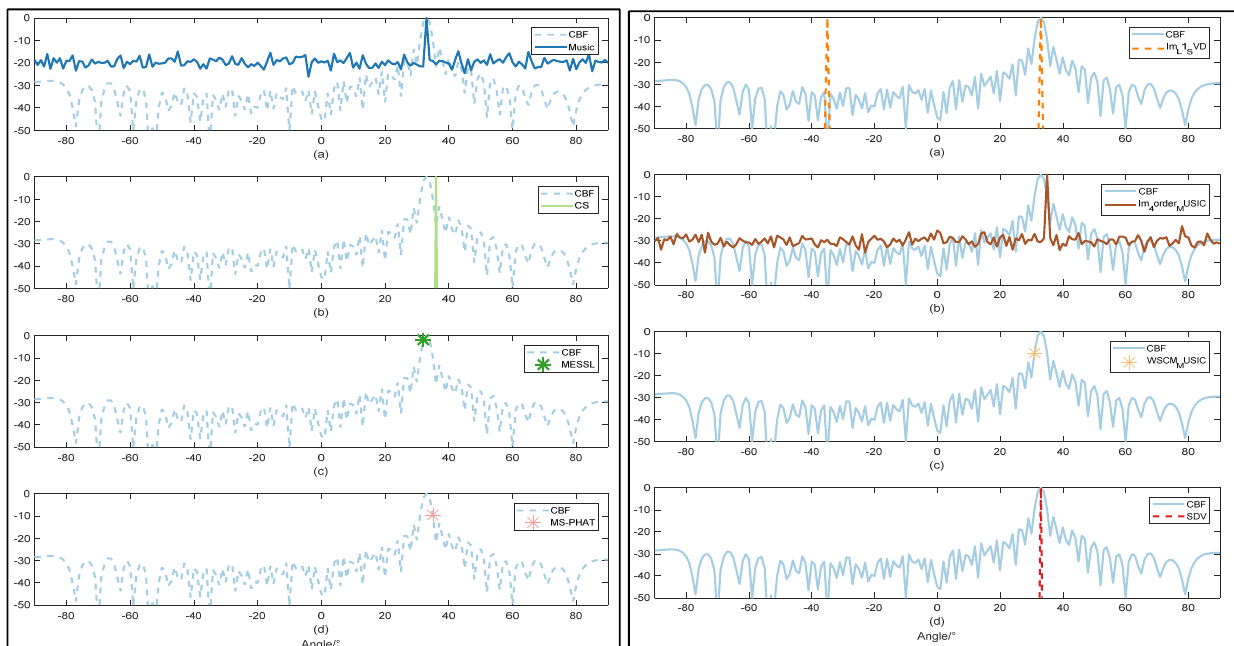
Figure 6. Comparison of direction estimation with SNR = 10 dB by 9 methods: CBF worked as a comparison in all figures. Music are shown in left ( a ) CS are shown in left ( b ). MESSL are shown in left ( c ) and MS-PHAT are shown in left ( d ). Im-L1-SVD are shown in right ( a ). Im-4order-MUSIC are shown in right ( b ). WSCM-MUSIC are shown in right ( c ) and proposed SDV are shown in right ( d ).